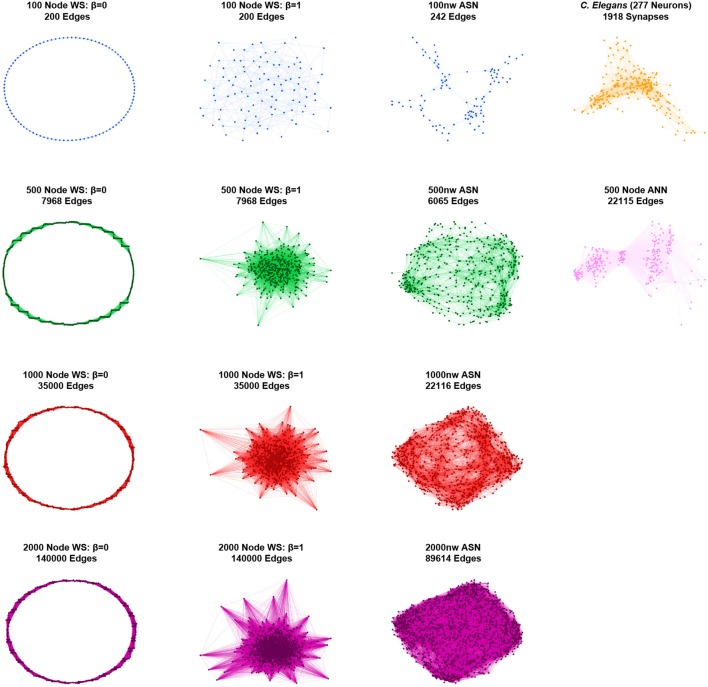
Graphical representations of sample networks: Grid-like Watts-Strogatz (WS) networks (β = 0; left); random Watts-Strogatz networks (β = 1; center-left); ASNs (center-right); C. elegans and fully-connected ANN networks (right). Nodes represent nanowires (or neurons for C. elegans and ANN), while edges represent junctions (or synapses for C. elegans and virtual synapses for ANN).